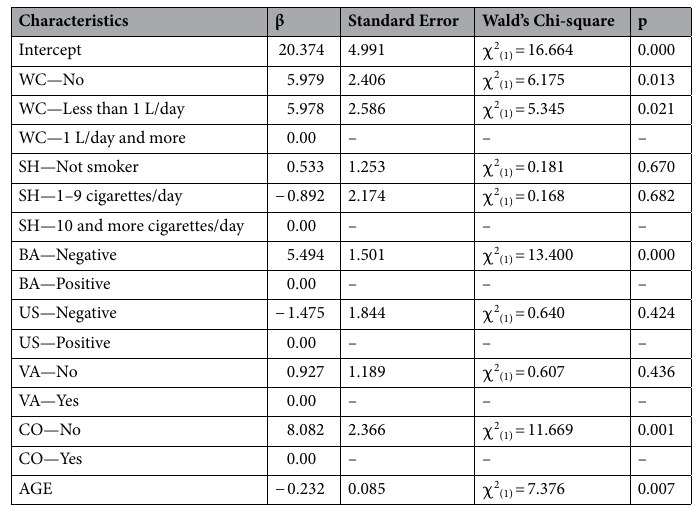
Table 5. Results of the generalized linear model with sperm progressive motility (SM) as response variable. WC wine consumption, SH smoking habit, BA semen bacteriological analysis, US urethral swab, VA varicocele, CO consanguinity.